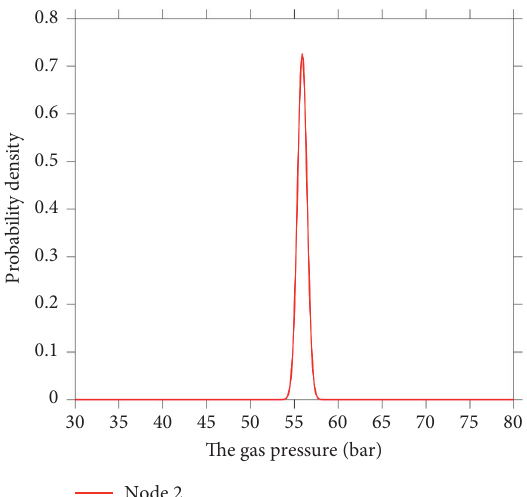
Figure 8: Probability distribution of pressure at node 3.